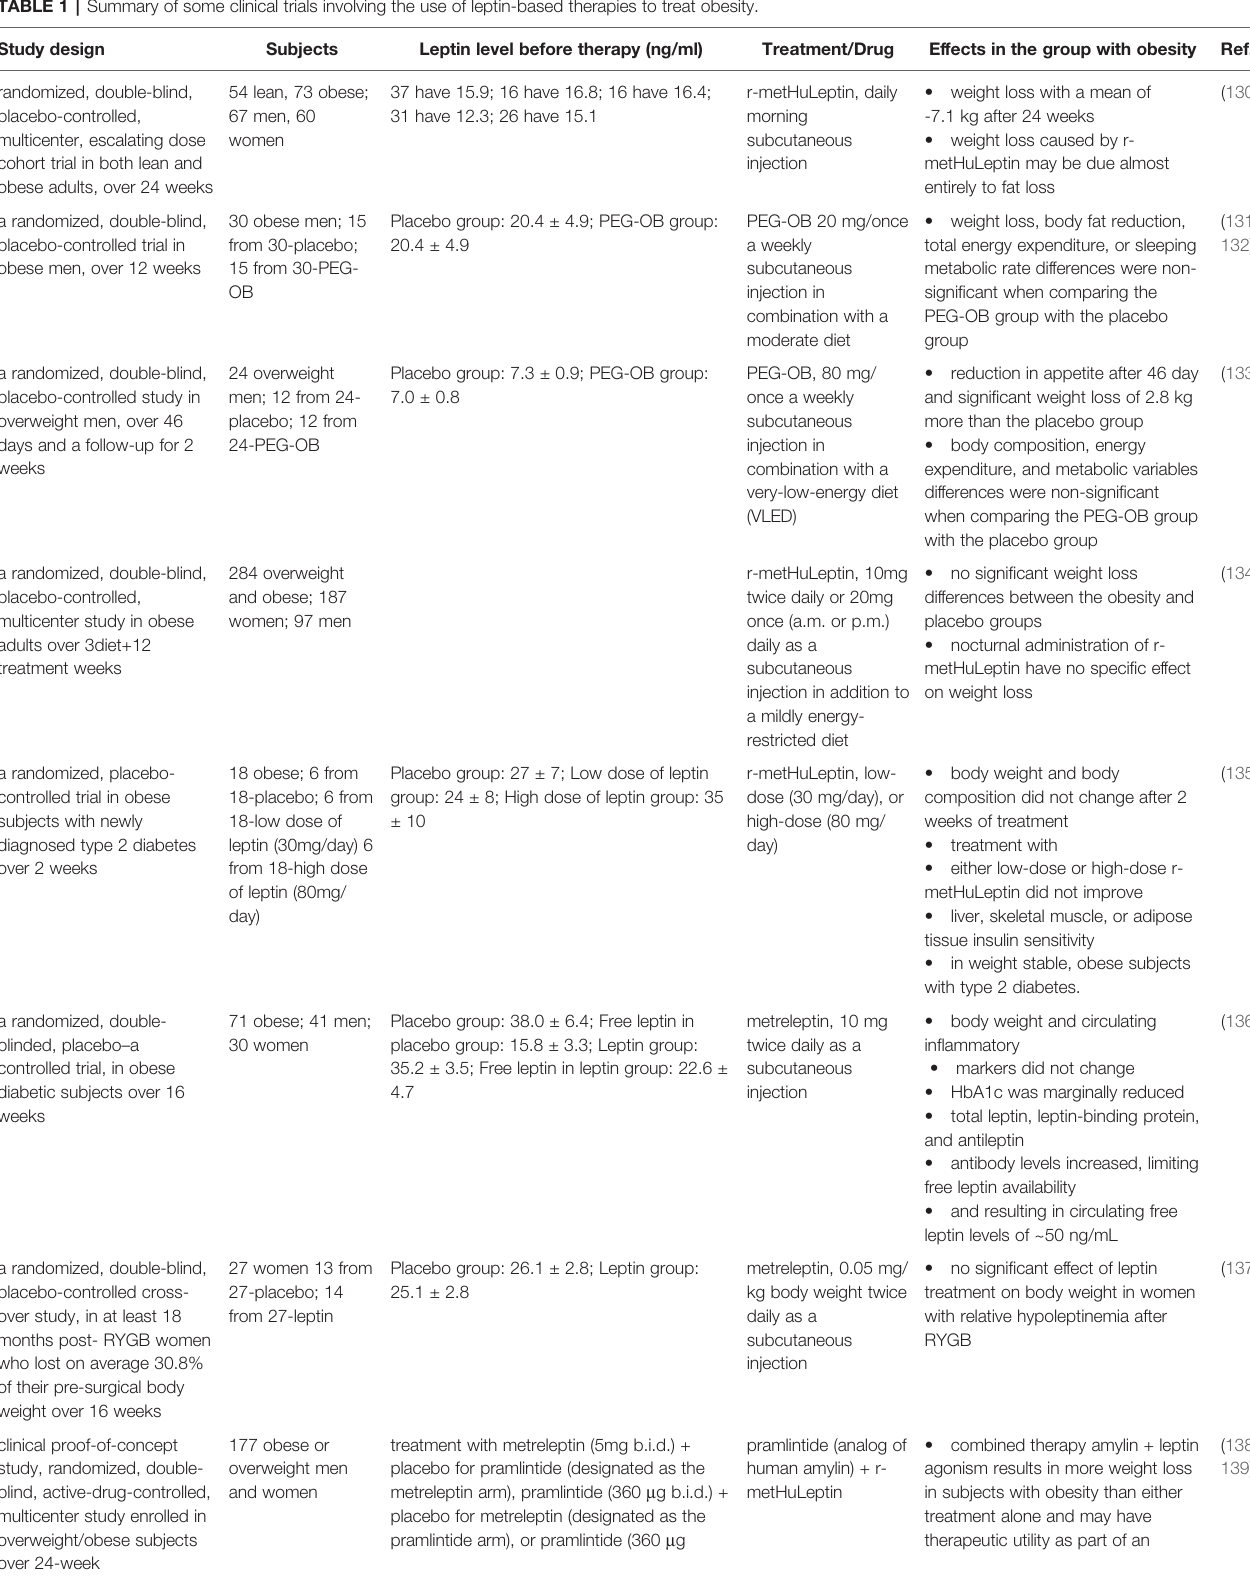
TABLE 1 | Summary of some clinical trials involving the use of leptin-based therapies to treat